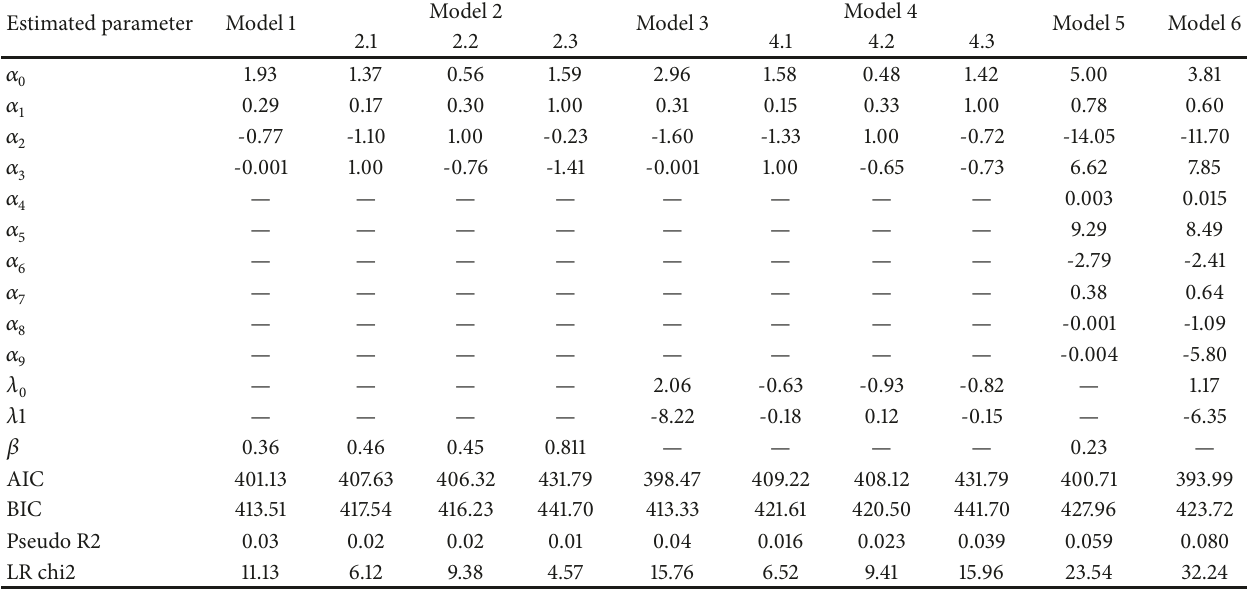
Table 5: Estimated and statistics parameters.